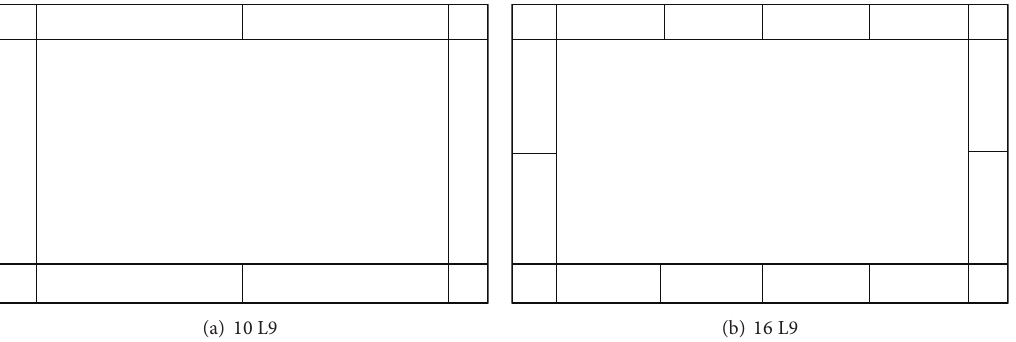
Figure 17: Distribution of L9 elements above the cross-section of the hollow-rectangular box beam.